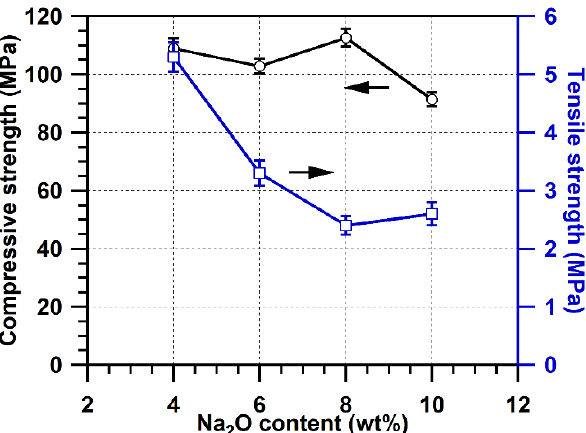
Figure 16. Compressive strength and tensile strength of alkali-activated slag paste with different water glass content (as alkali equivalent) at 28 days.